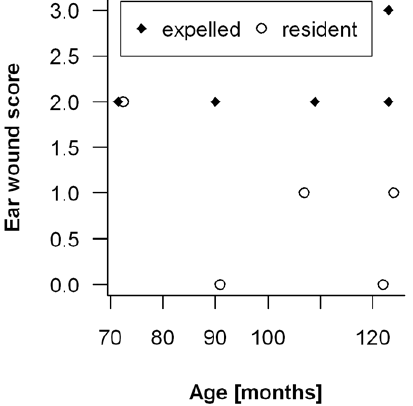
Figure 3. Ear wound score for adult owl monkeys. Ages for individuals that were still resident ( ¤ ) in a breeding group or recently expelled ( # ) are matched.